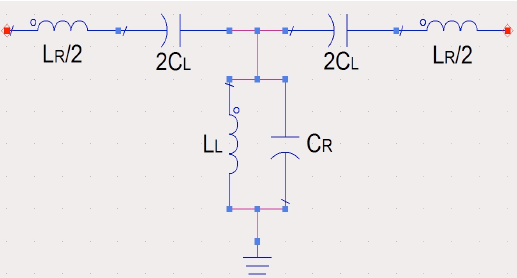
Figure.2. Equivalent circuit model of the CRLH MTM unit